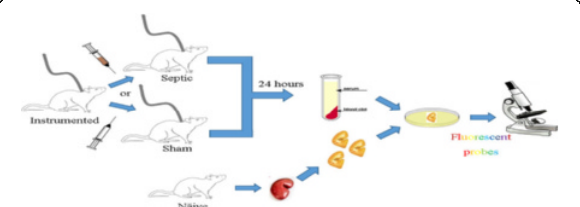
Fig. 60 (abstract A144). General overview of the relationship between the in vivo and ex vivo models of sepsis described in the text. Rats are instrumented and following surgical recovery are administered with an intraperitoneal injection of either faecal slurry or normal saline. At 24 hours the animals are culled and blood removed. The blood is processed into serum and used for further experiments using slices of kidney tissue from a naïve rate. Serum and kidney slices incubated together may be examined for dynamic changes in mitochondrial function using fluorescent probes under a two-photon laser microscope